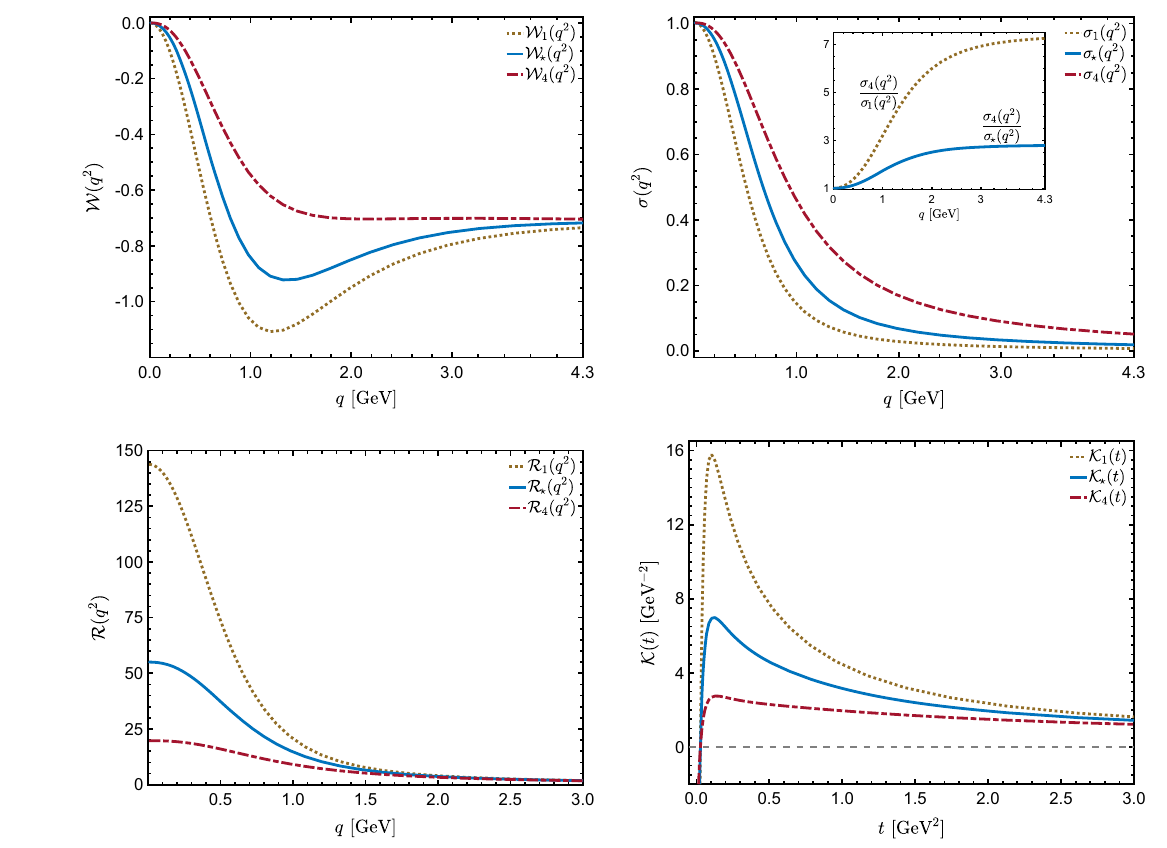
( q 2 ) . Bottom left panel: The ratios R σ (cid:20) ( q 2 ) , and σ 4 ( q 2 ) , defined in Eq. (5.1). Bottom right panel: The integrands K R 4 ( t ) , given by Eq. (5.1) K (cid:20) ( t ) , and K 4